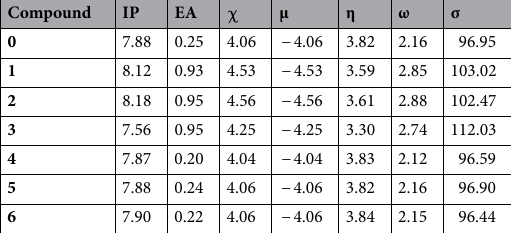
Table 4. Global reactivity descriptors (GRD) of compounds 0 and 1 – 6